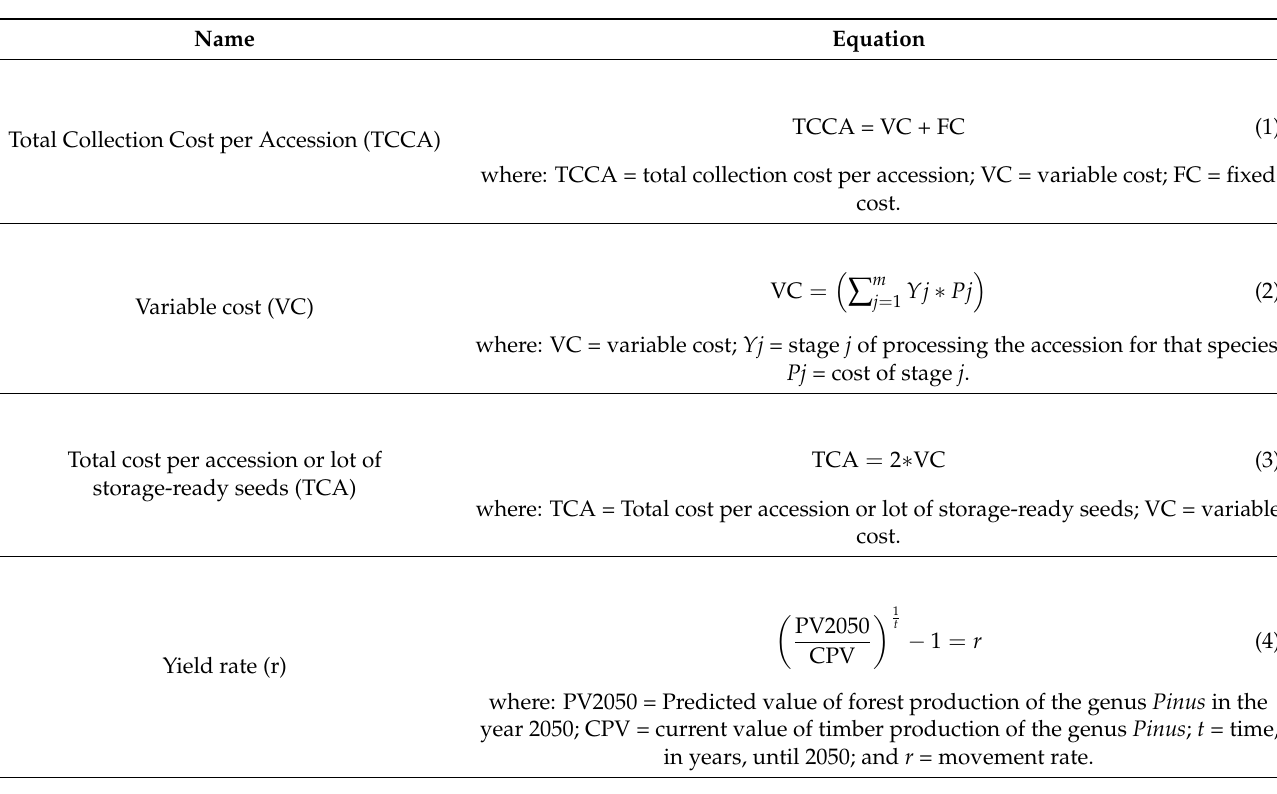
Table 2. Summary of equations utilized in this